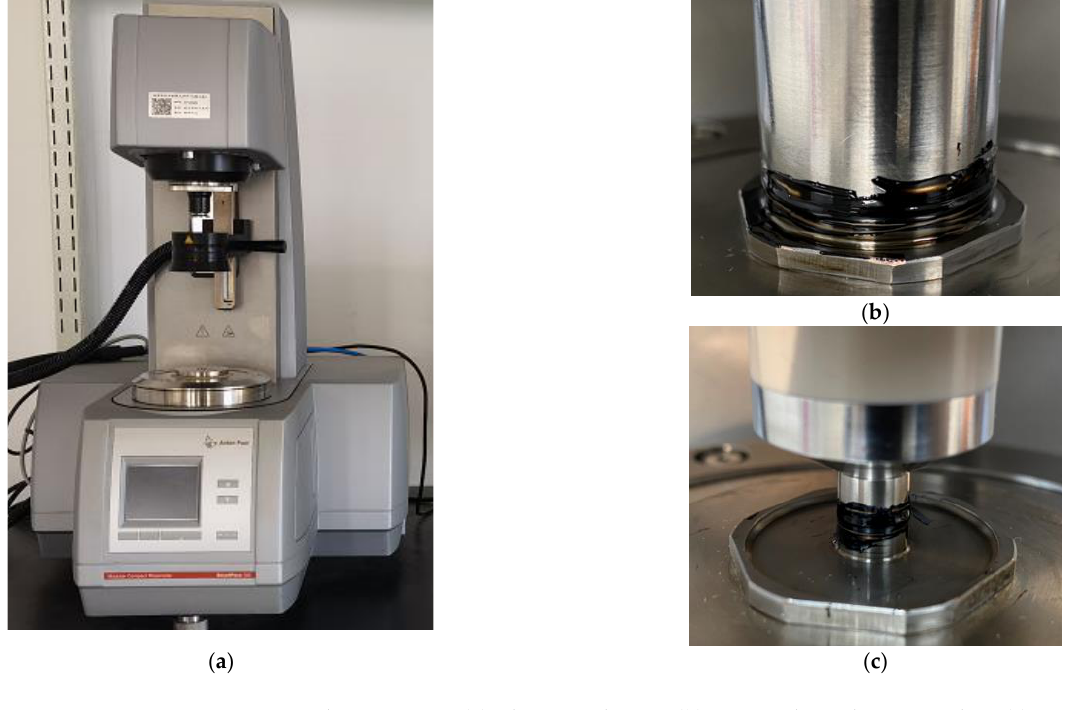
Figure 2. The DSR test: ( a ) The DSR device; ( b ) A sample with 25 mm dia.; ( c ) A sample with 8 mm dia. 8 mm